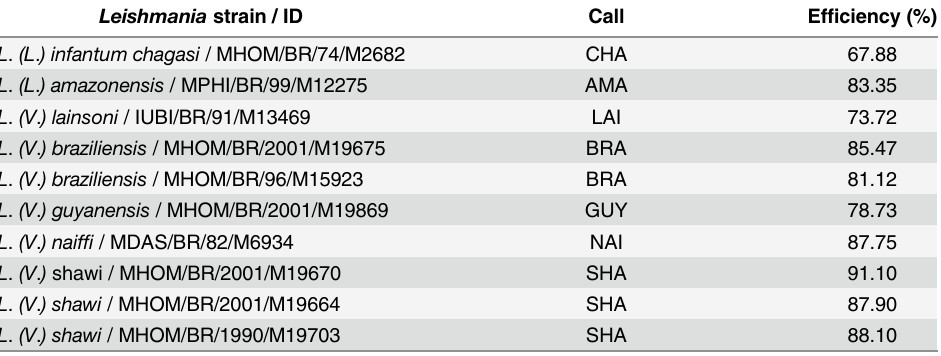
Table 3. Call efficiency obtained in the HRM analysis targeting the hsp70 gene of different Leishmania strains The “ call ” column shows the names given by the software to the unknown samples based on names given to the reference samples: L . (L . ) infantum chagasi (CHA), L . (L . ) amazonensis (AMA), L . (V . ) lainsoni (LAI), L . (V . ) braziliensis (BRA), L . (V . ) guyanensis (GUY), L . (V . ) naiffi (NAI) and L . (V . ) shawi (SHA). Each con- dition was tested in duplicate in three independent